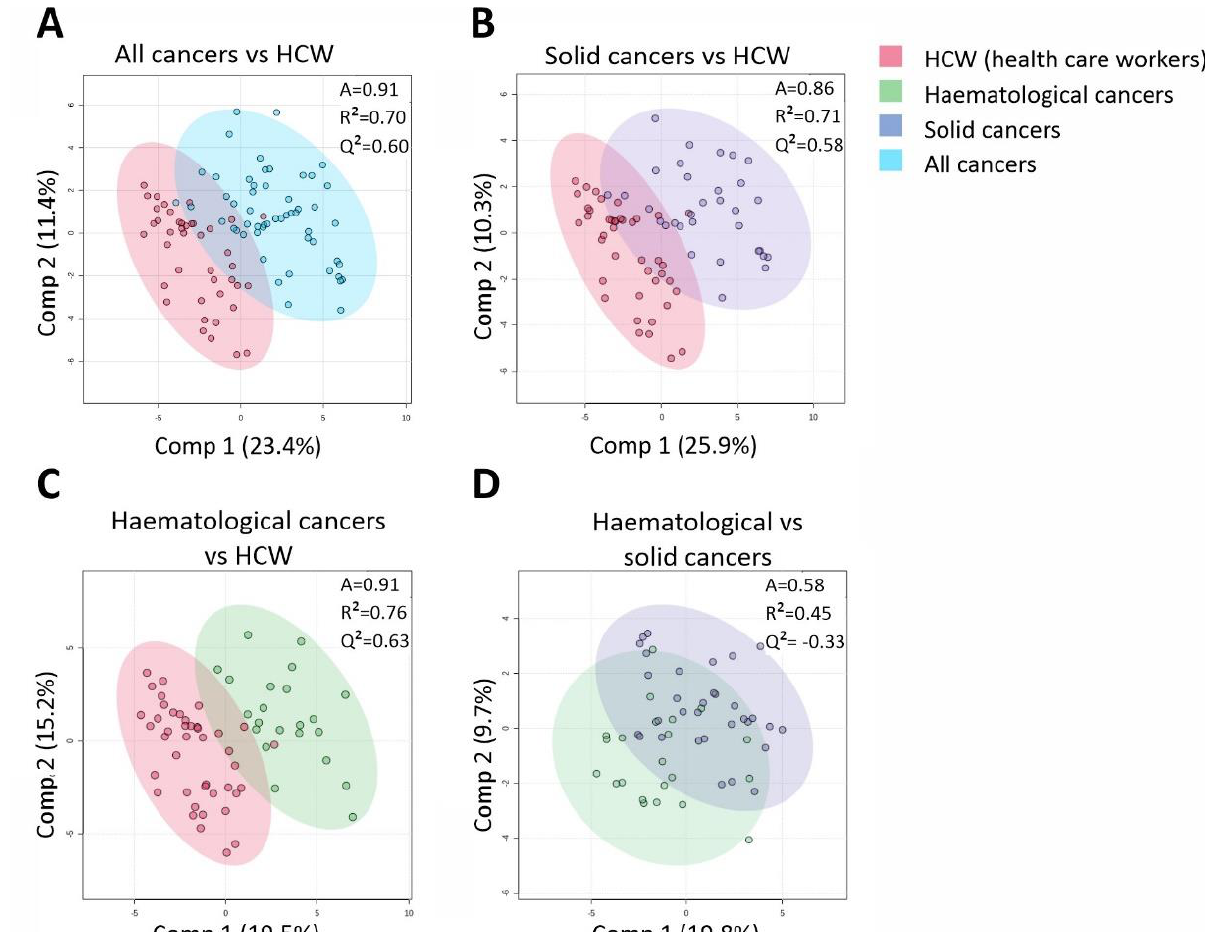
Figure 2. Cluster analysis of CCGs in unexposed individuals with partial least-squares discriminant analysis (PLS-DA) reveals larger differences between health care workers (HCWs) and cancer as a group or individually as solid and haematological groups, than between the two cancer groups. ( A ) The comparison of HCWs with the two different cancer types pooled. ( B ) The comparison of the HCWs with patients with solid tumours ( C ) and with haematological malignancies ( D ) Comparison of haematological versus solid cancer patients. A, accuracy.